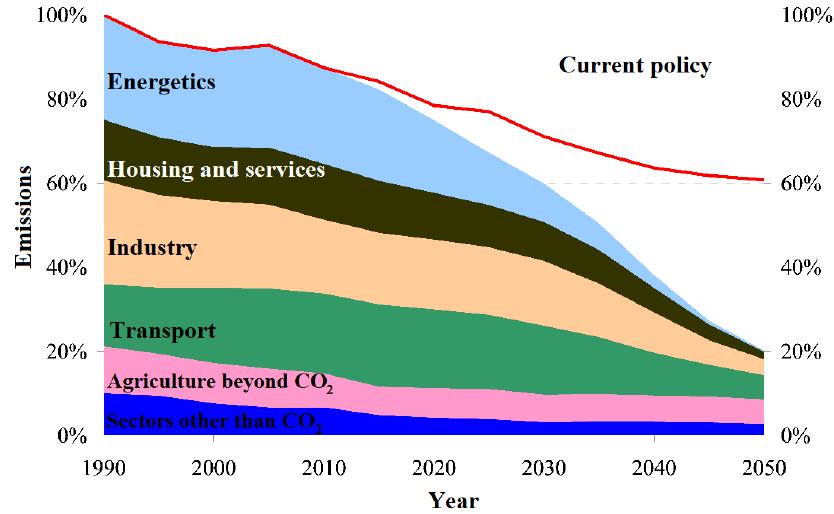
Figure 2. The course of reducing greenhouse gas emissions in the EU by 2050 (1990 = 100%)